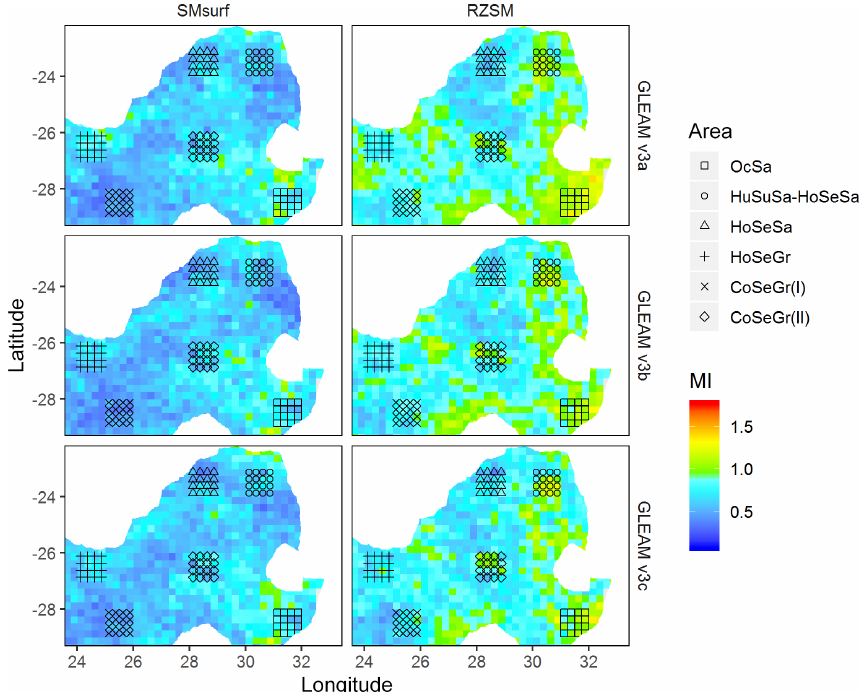
Figure 7. Mutual information (MI) computed on the residuals of monthly time series (2011–2014) of surface (SMsurf, 0–10cm) and root- zone (RZSM, 10–100cm) soil moisture, between CCAM-CABLE simulations and GLEAM models estimates. The studied sub-regions of interest are represented by different shapes on the maps, namely oceanic savanna (Ocsa), humid subtropical and hot semi-arid savanna (HuSuSa-HoSeSa), hot semi-arid savanna (HoSeSa), hot semi-arid grassland (HoSeGr), and cold semi-arid grassland